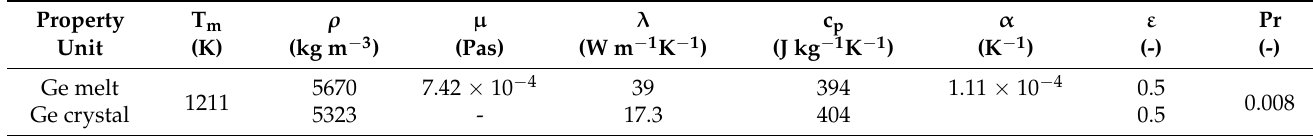
Table 1. Material properties of Ge melt and crystal.